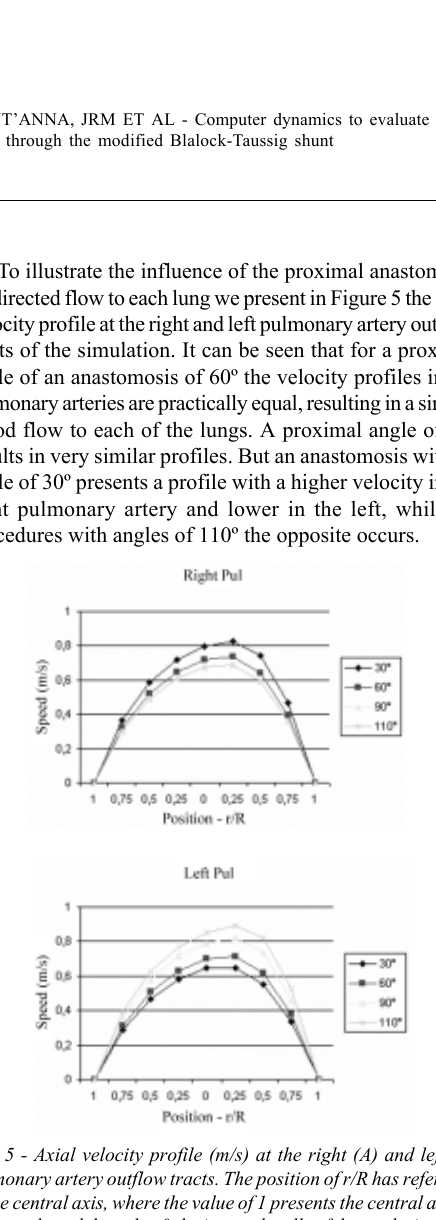
drop is practically the same for the different angles of the proximal anastomosis and for different diameters of the PTFE graft, and it is located at the same point of the subclavian artery.